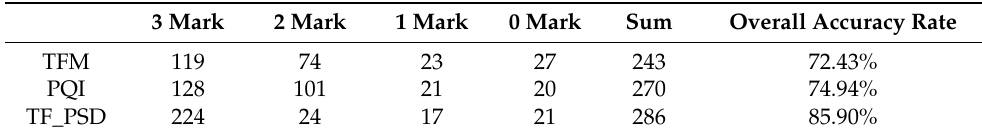
Table 8. Comparison of the recognition accuracy rates of different